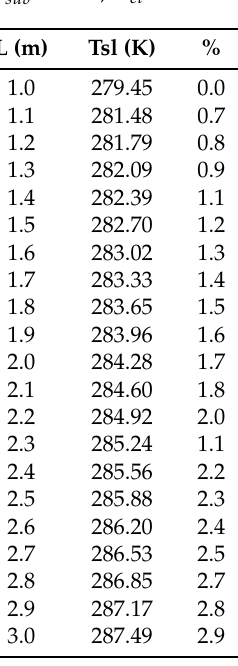
Table 4. Sensitivity analysis with respect to capillary tube length T cond = 54 ◦ C; T evap = − 3.7 ◦